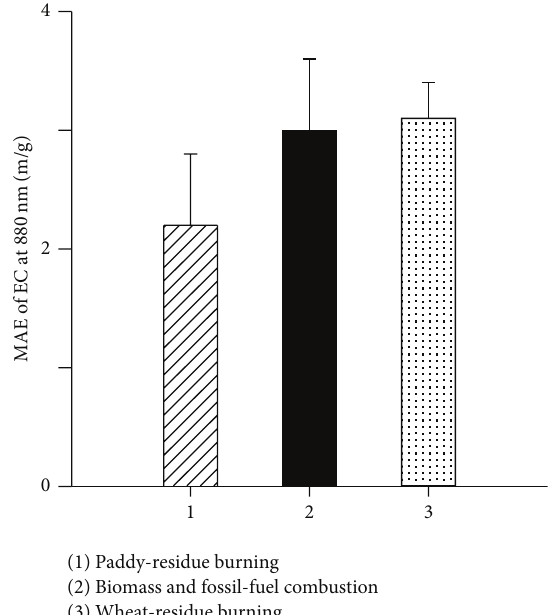
Figure 6: Mass absorption efficiency (MAE; m 2 g −1 ) of EC at 880 nm during different emissions in Northern